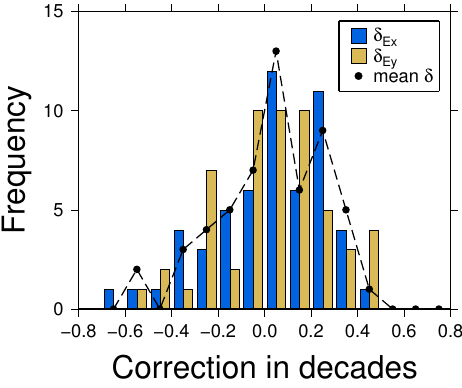
Figure 8. Distribution of calculated static correction factors δ E (blue) and δ E (yellow) in decades (i.e. as additive factors, where y + 0.5 corresponds to a multiplicative factor of 10 0 . 5 , ≈ 3). Statistical quantities related to these distributions are tabulated in Table 1.